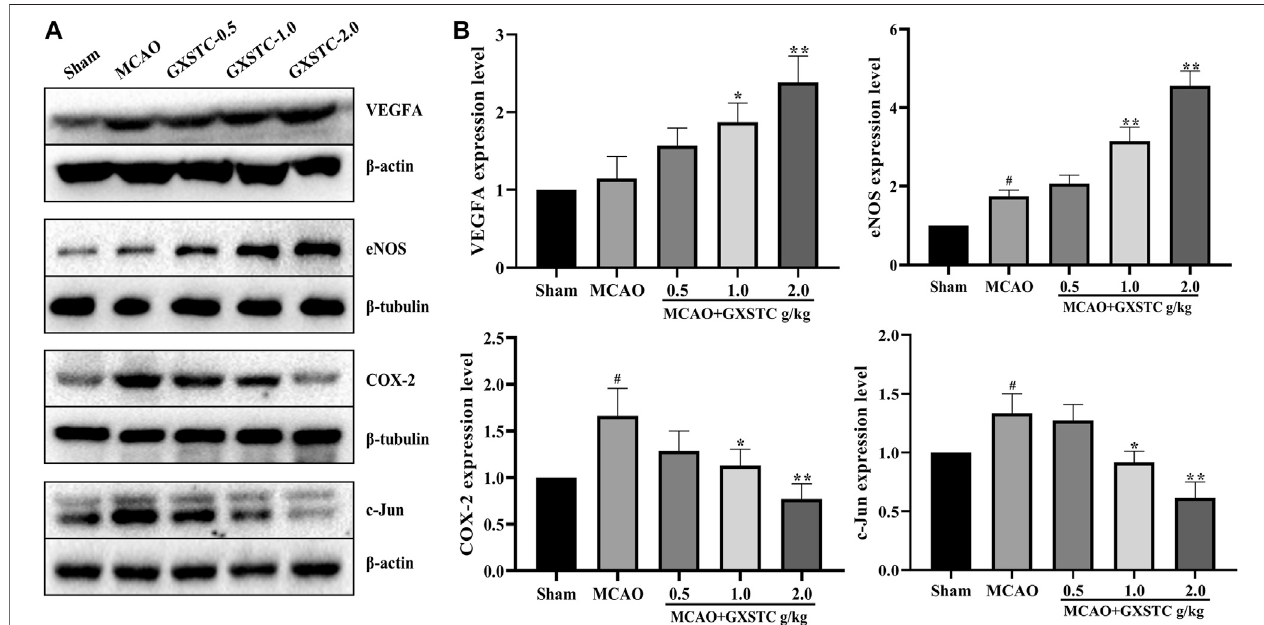
FIGURE 9 | Relative expression of VEGFA, e-NOS, COX-2, and c-Jun in the cerebral cortex of the sham, MCAO, 0.5, 1.0, 2.0 g/kg GXSTC pretreatment groups were detected by using Western blot analysis. Representative bands exhibited the relative expression of VEGFA, e-NOS, COX-2 and c-JUN (A) ; Statistical analysis resultsofdetectedproteinsineachgroup (B) .Datawerepresentedasmean ± SD.# p < 0.05,comparedwiththeshamgroup;* p < 0.05or** p < 0.01,comparedwiththe MCAO